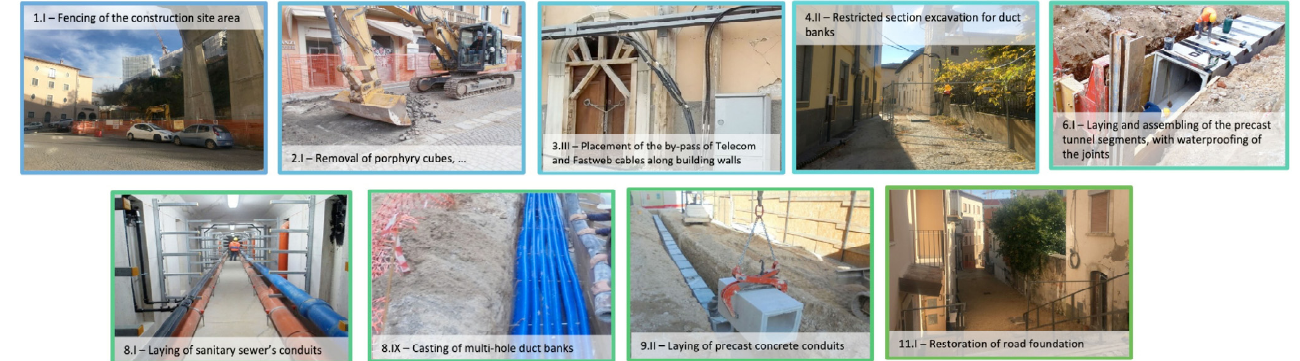
Figure 4. Detailed work phasing for the realization of the utility smart tunnel in L’Aquila. Thirteen working phases have been identified and each of them was subdivided in sub-phases (or activities). These phases stretch from the construction site set-up (phase n. 1) to its dismantling (phase n. 13). In the figure, photographic documentation of some of the sub-phases has been provided.The coordination between this construction plan and the site subdivision strategy allowed for parallel execution of the work (Figure 5) to reduce the project duration and reduce the laydown areas. At the same time, the adoption of the prefabricated elements further sped up the process, reducing the on-site energy demand with a lower impact on the urban environment.